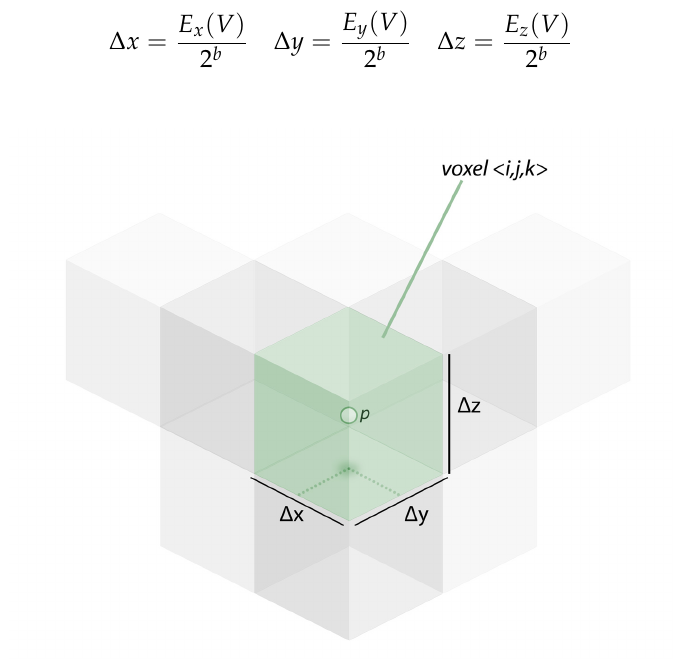
Figure 2. Decoding 3D location ( p ) from a quantized RGB value (voxel < i , j , k > ∈ V